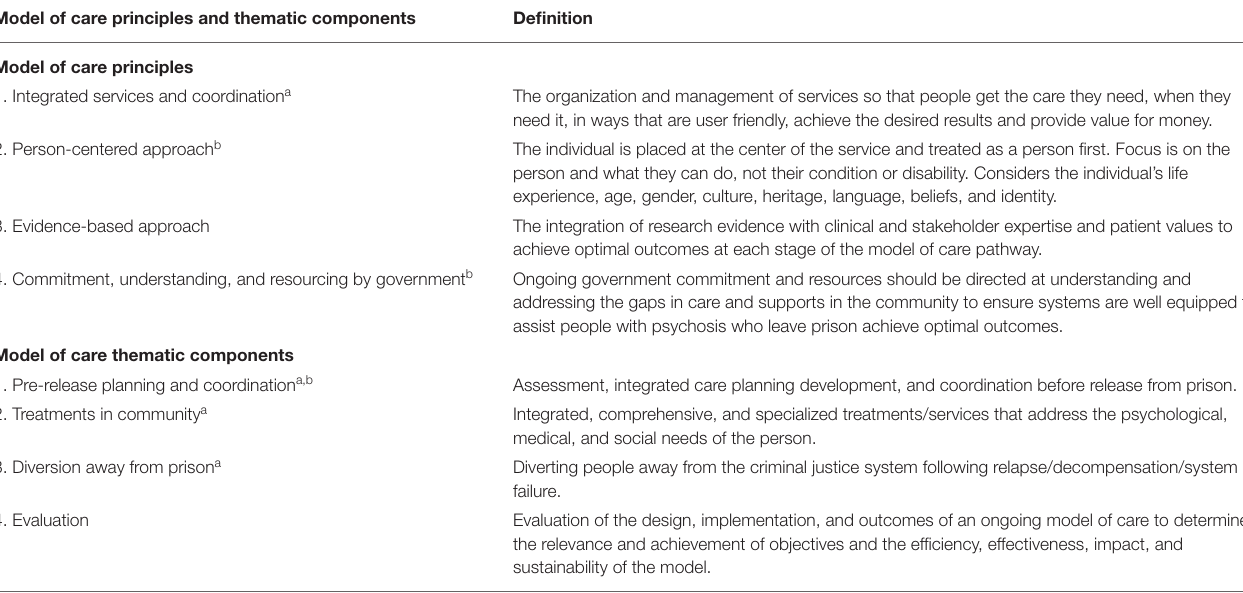
TABLE 1 | Principles to underpin, and thematic components of, an optimal model of care for people with psychosis leaving prison, as identified by participants. Model of care principles and thematic